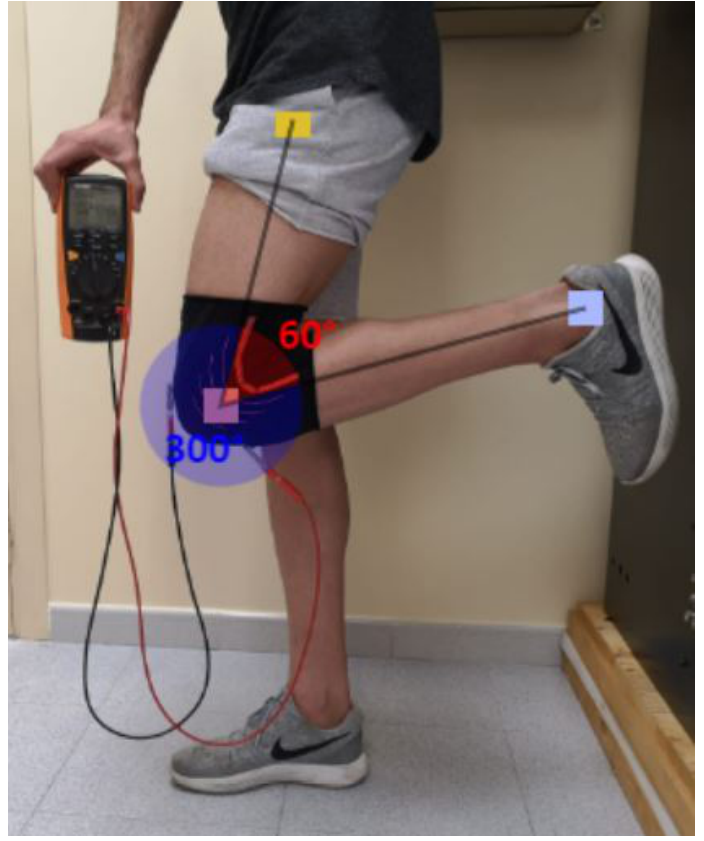
Figure 5. Characterisation of Knee flexion versus sensor resistance on